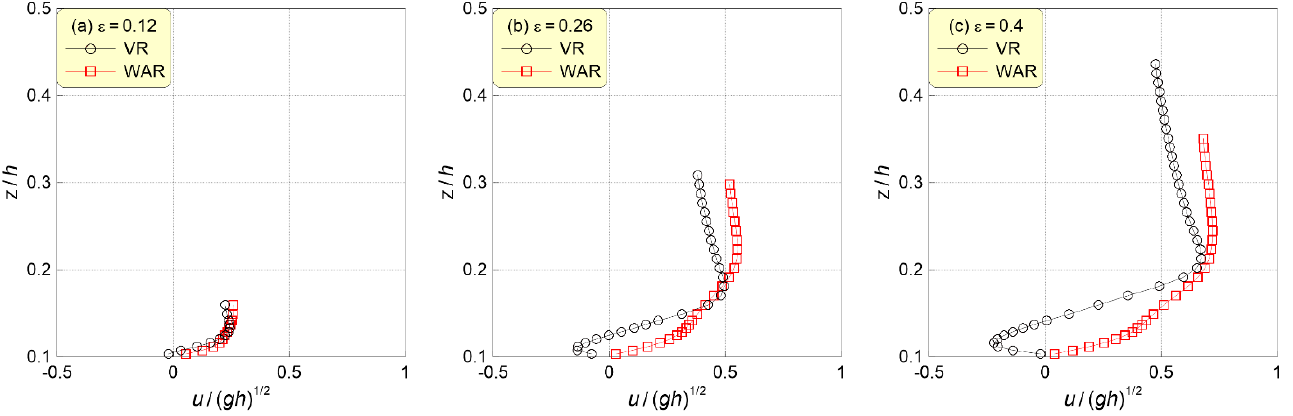
Figure 20. Vertical distribution of horizontal velocity at the center of the separated region — comparison between VR and WAR; ( a ) 𝑥